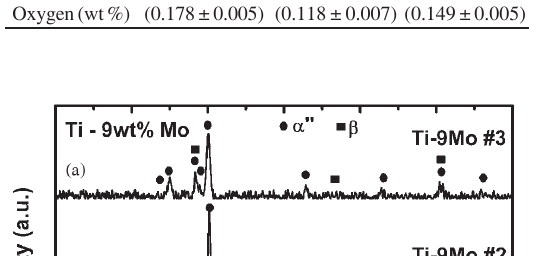
Table 2. Interstitial oxygen content of the Ti-9Mo samples used in this study. Sample